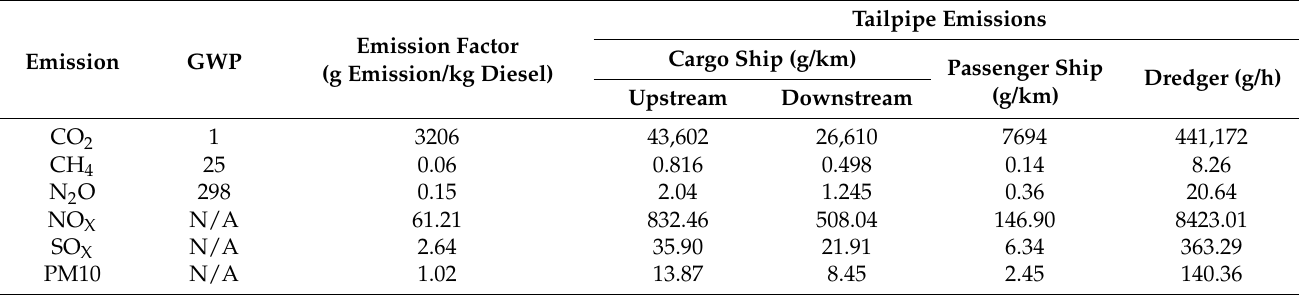
Table 5. Calculated tailpipe emissions from the considered diesel engine-powered